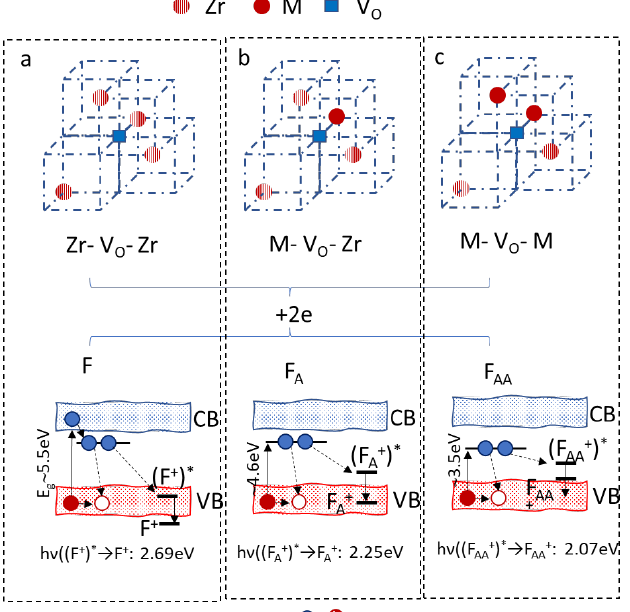
Figure 8. Schematic representation of the different F centers expected in this system [9–12] (upper) and the corresponding recombination paths (lower). ( a ) Reactions 1, 3 and 4; ( b ) reactions 5 and 6; ( c ) reactions 7 and 8. The asterisk (*) means excited state.